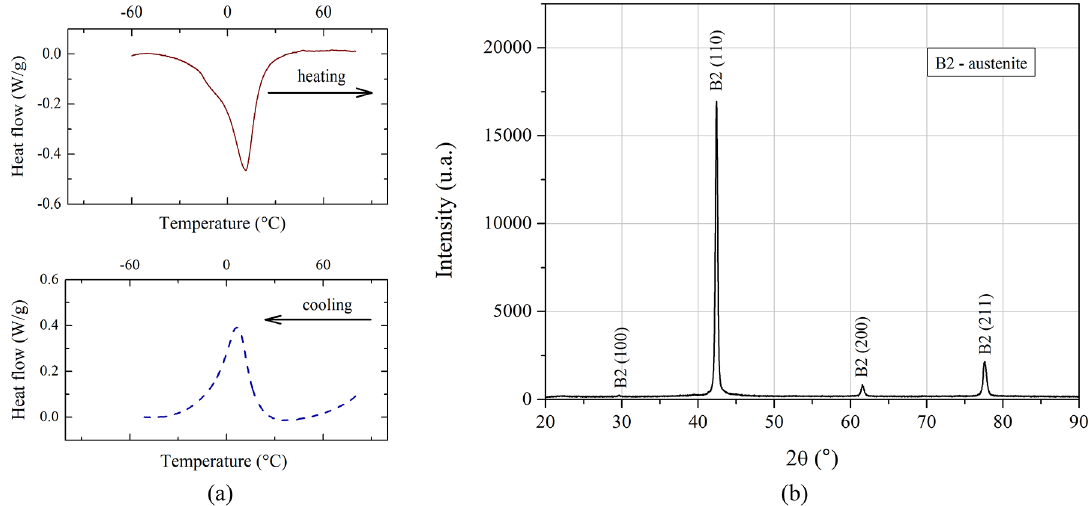
Figure 2. Initial characterization of the Ni-Ti wire as-received: (a) DSC curve; (b) X-ray diffraction profile. Table 1. Average transformation temperatures values of the Ni-Ti wires determined by DSC. Transformation temperatures (°C)